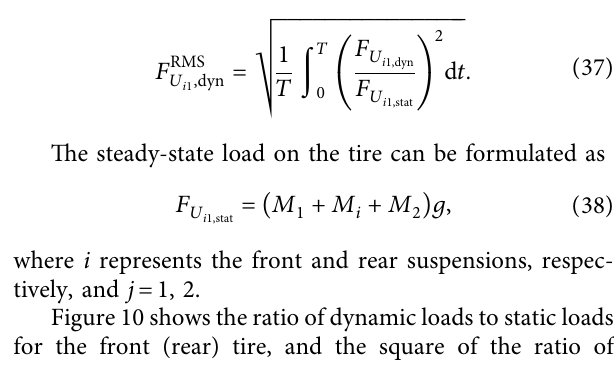
represents the n � ( U , U , U ) T , respectively. Simulation period T � 10 n 5 4 3